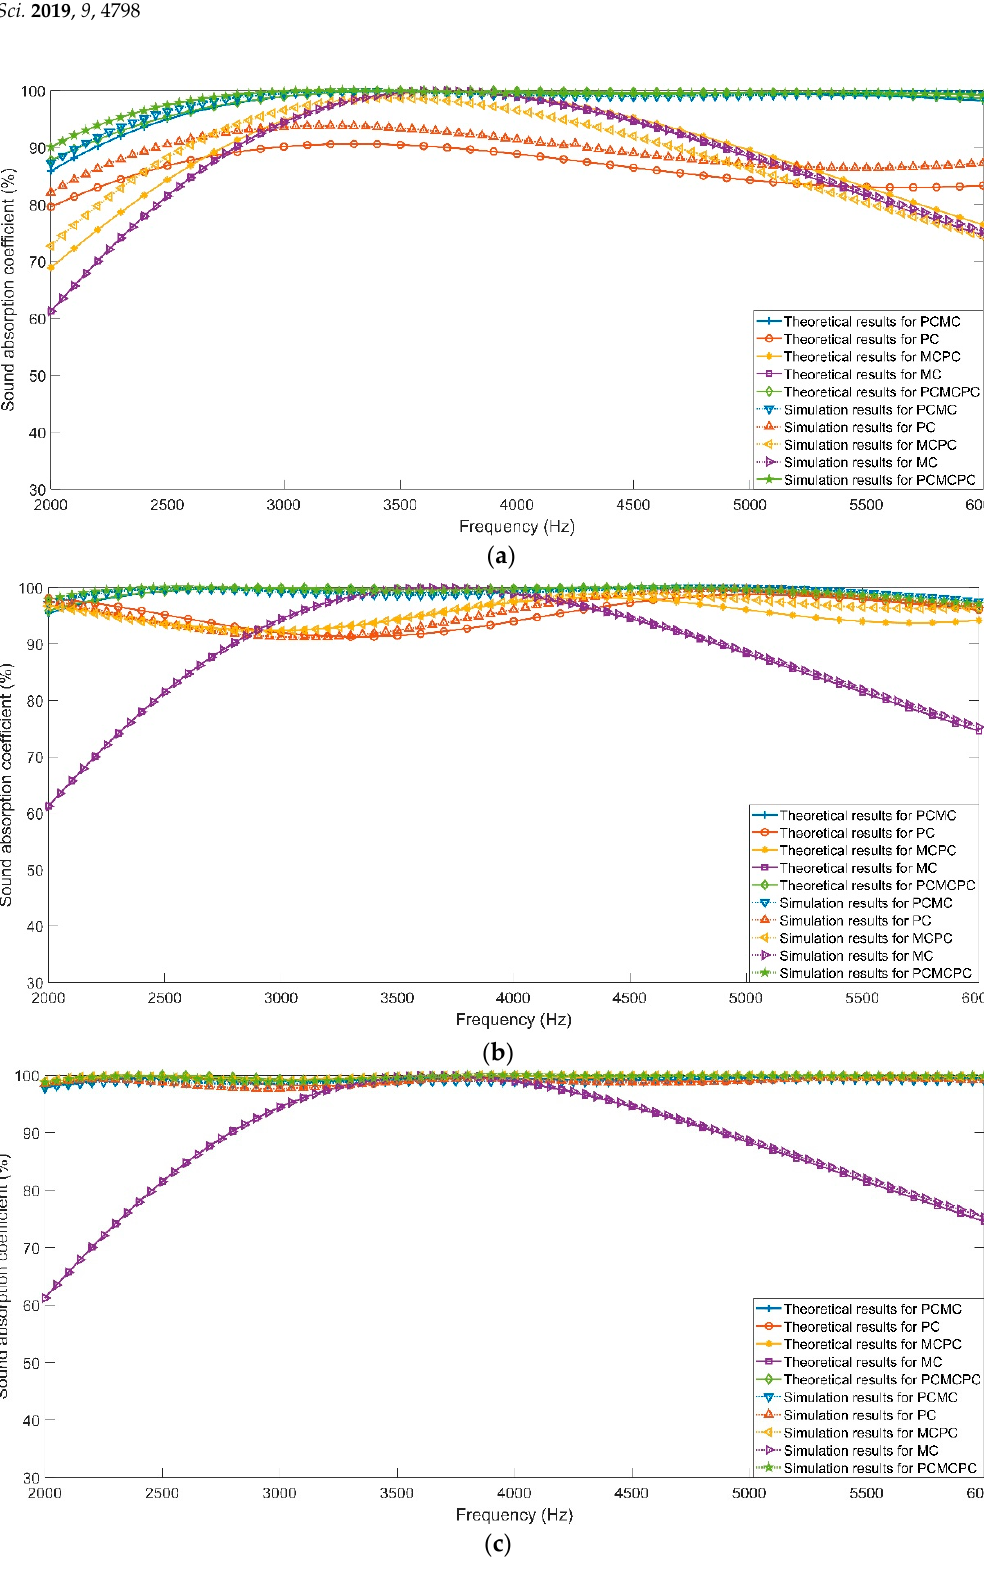
Figure 6. Comparison of the sound absorption coe ffi cient in theory and that obtained by simulation. ( a ) Composite structures with limited total thickness 30 mm corresponding to parameters in Table 3; ( b ) composite structures with limited total thickness 50 mm corresponding to parameters in Table 4; ( c ) composite structures with limited total thickness 100 mm corresponding to parameters in Table 5.